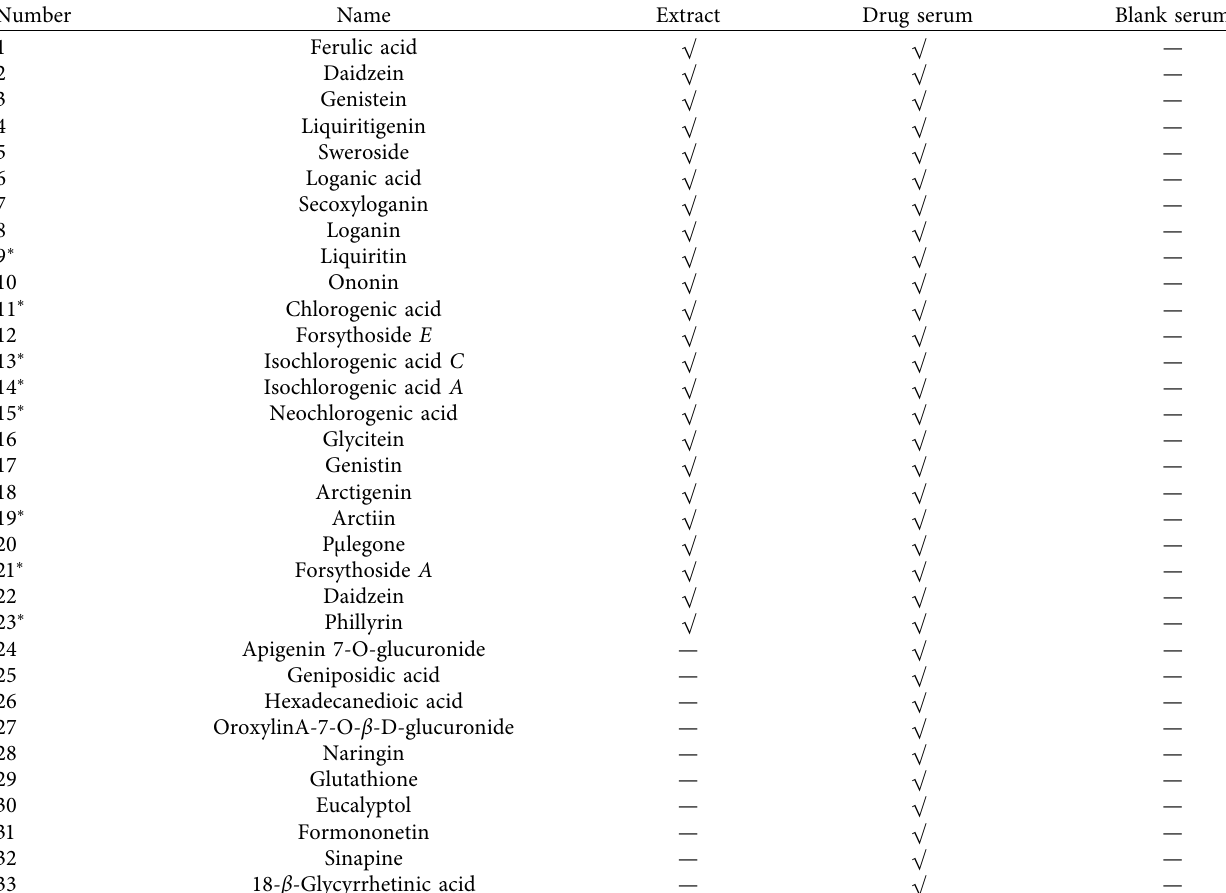
Table 4: Information of blood components in Yinqiao powder.